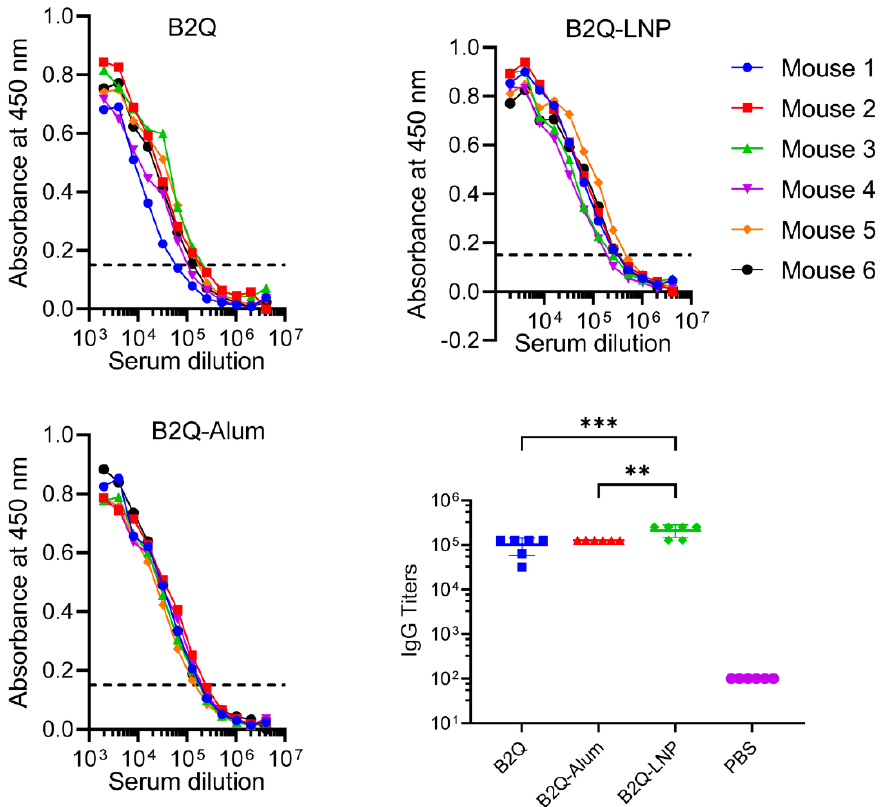
Figure 5. Humoral responses of mice in the LNP encapsulation study. For ELISA analysis of each serum sample from immunized mice, the horizontal coordinate is the fold change in the serum dilution, and the vertical coordinate is the absorbance value measured at 450 nm. The dashed lines (OD 450 = 0.15) were set as the cutoff signal for the values of IgG titers. For statistical analysis, each dot represents data from a single mouse, N = 6. Data are shown as the mean ± SD and were analyzed by ANOVA, with the mean of the B2Q-LNP group used as a control. ** p ≤ 0.01; *** p ≤ 0.001.